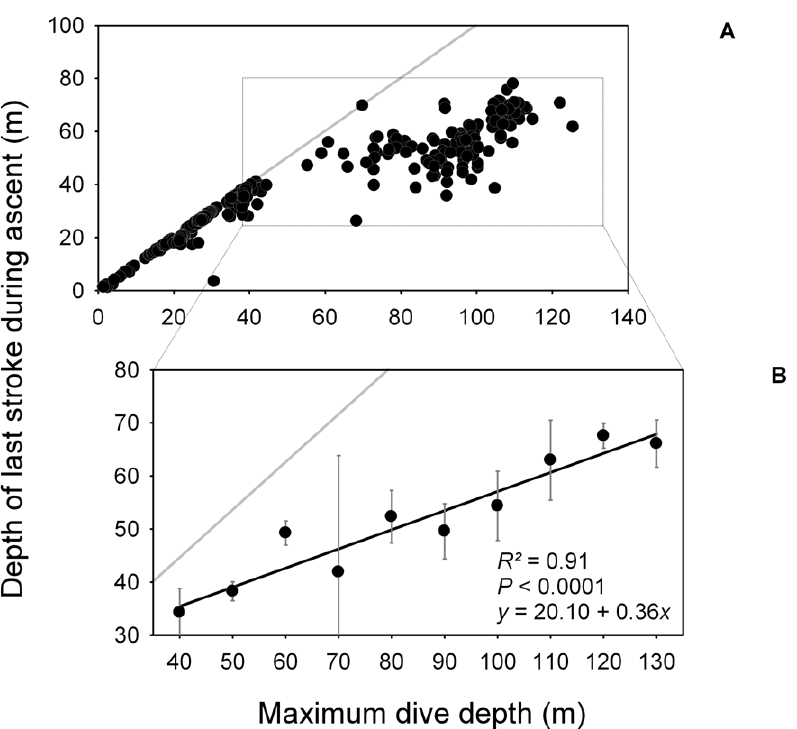
Figure 7. (A) Depth of last foot stroke during ascent in relation to maximum dive depth for all birds and (B) close up for dives strictly . 40 m, where depth of last foot-stroke is shallower than maximum dive depth. Because dives are flat-bottomed, maximum dive depth is a good proxy of depth of end of bottom phase (mean difference =0.9 6 1.5 m). For dives , 40 m, depth of last foot-stroke during ascent is similar to maximum dive depth, birds gliding from the bottom back to the surface (grey line: y = x ). For dives . 40 m, the depth where the last stroke occurs increases with maximum dive depth (each point is the mean 6 S.D. of individual means within each 10 m depth class); the linear regression for this relationship is the black line (grey line: y = x